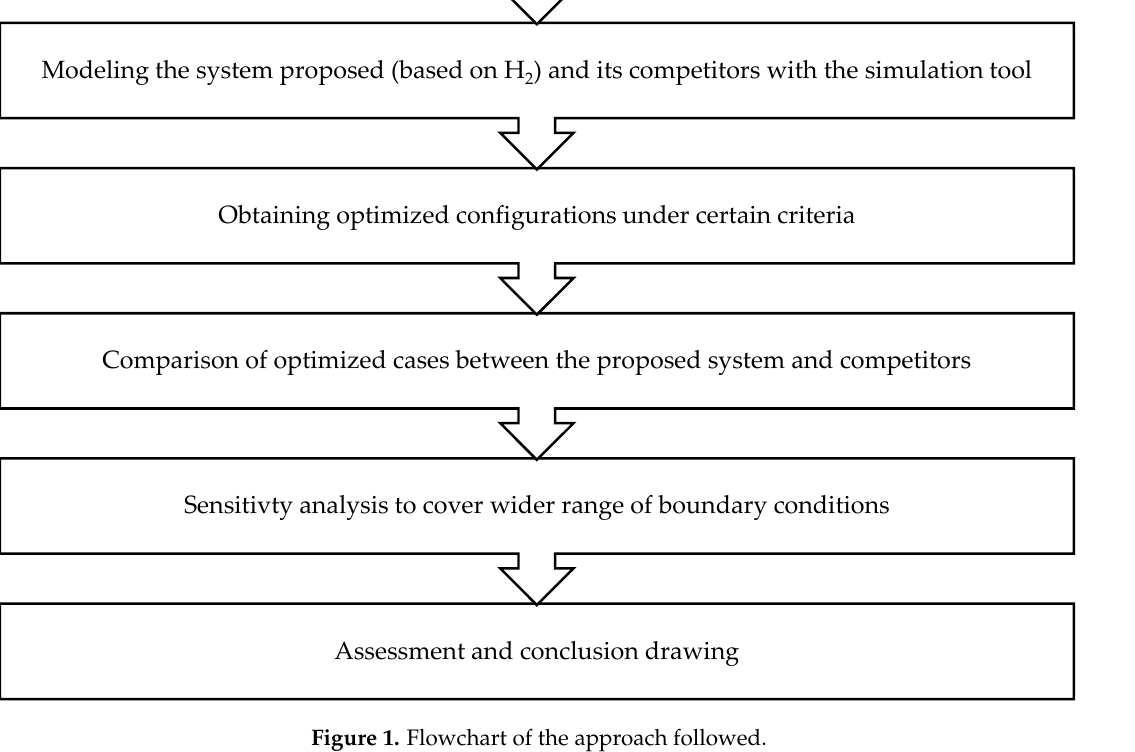
Figure 1. Flowchart of the approach followed.